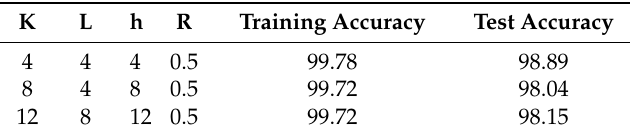
Table 5. Performance of EECGNet on